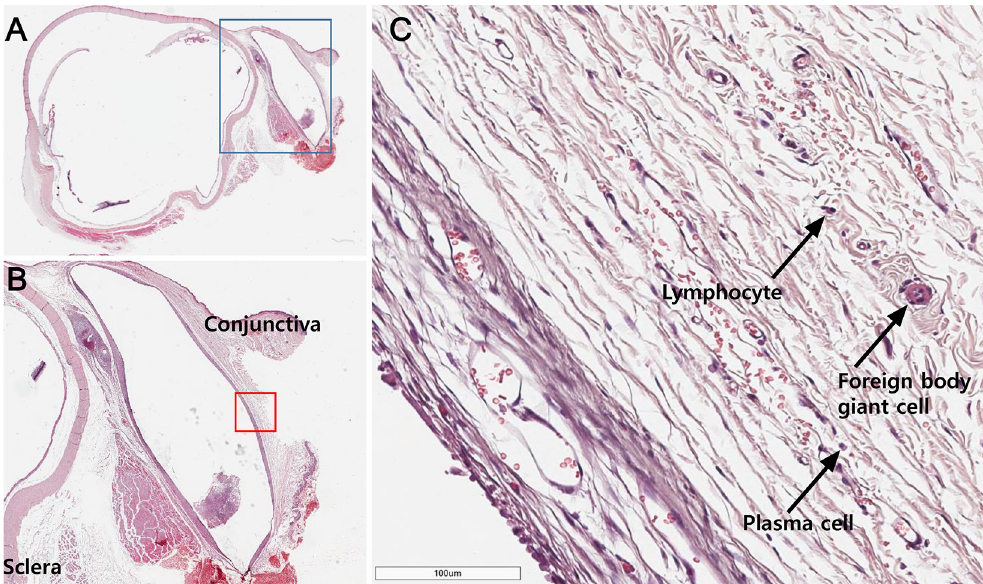
Fig 2. Methods for measuring the average inflammatory cell count. (A) Hematoxylin and eosin staining of a microsection crossing the midline of the implant. The blue box indicates the surgical site. (B) 8 × magnified image of the blue box in Fig A. The number of inflammatory cells in the tissue surrounding the implant was counted, following which the average number of cell counts of each group was calculated. (C) 200 × magnified image of a red box marked in Fig B. Various inflammatory cells such as lymphocytes, foreign body giant cell, plasma cells are